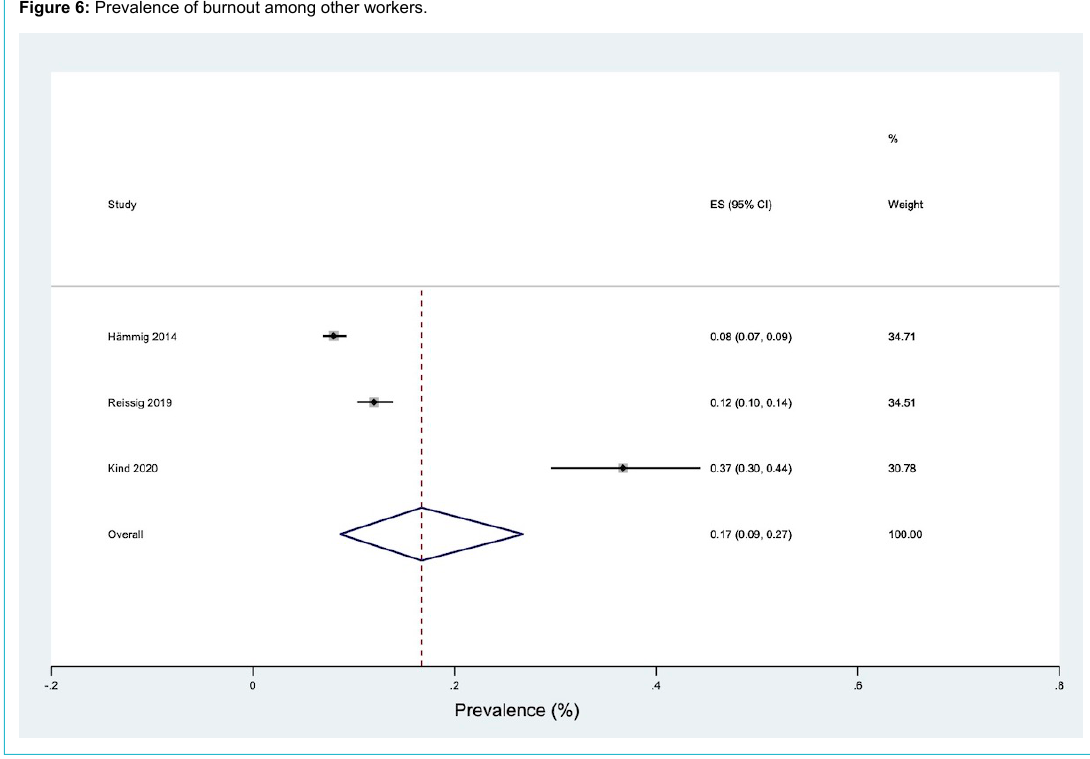
Figure 6: Prevalence of burnout among other